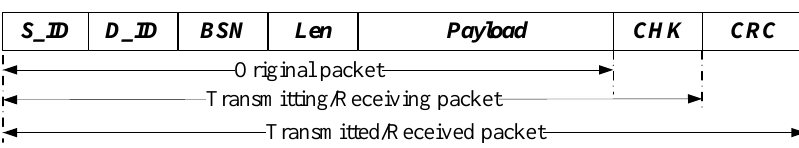
Figure 3. Structure of a Typical Data Packet in SAL-SAODV protocols.